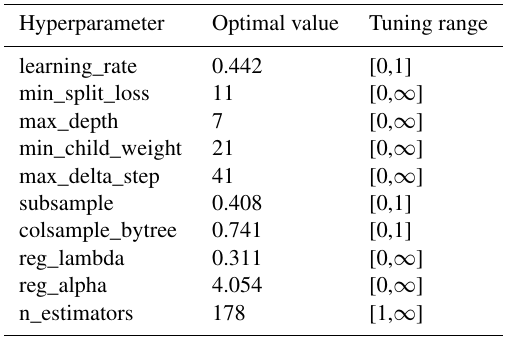
Table 3. Optimal value of the XGBoost model